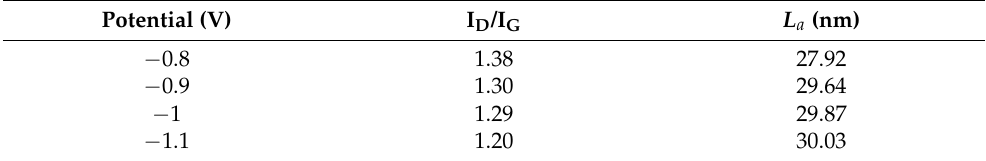
Table 2. Intensity ratio I D /I G and crystallite size ( L a ) of G for samples of ZnO/G/Cu.